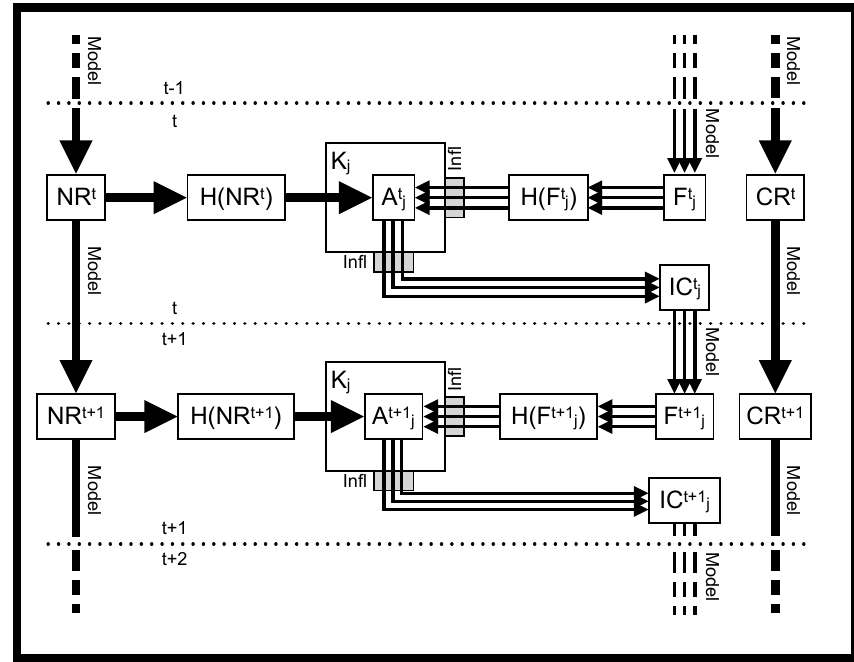
Figure 2. The cycling sequence with BEATBOX, with the assimilation window t , the assimilation method j , control run CR, nature run NR, observation operator H , gain K , analysis A , initial condition IC, and forecast F